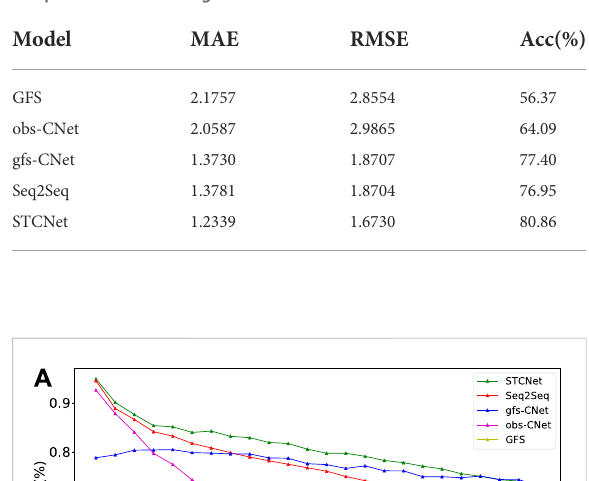
TABLE 2 Comparison of different methods regarding 2-m temperature forecasting.